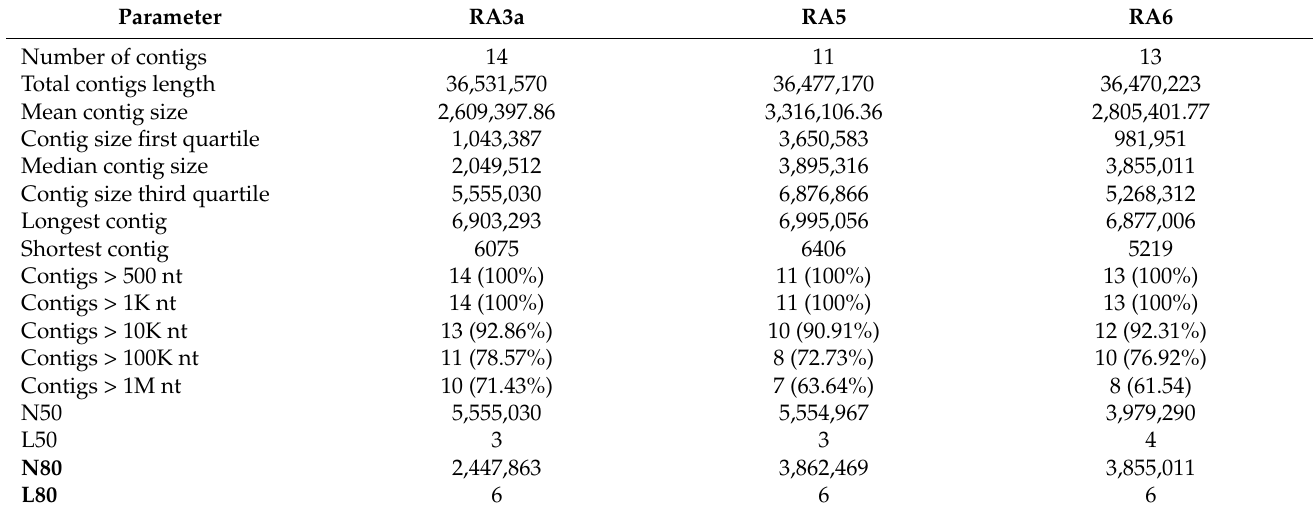
Table 4. Details of genome assembly statistics of the three Trichoderma isolates RA3a, RA5, and RA6.